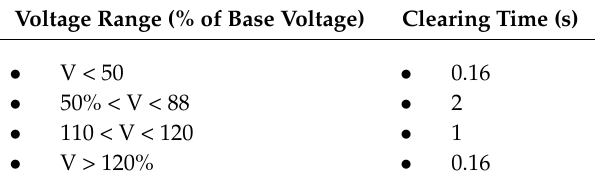
Table 3. Voltage relay responses.